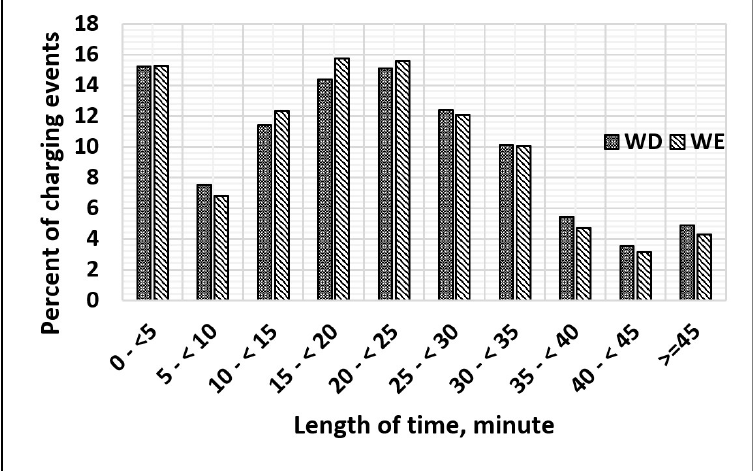
Figure 11. Distribution of length of time with a vehicle connected to an FCS per charging event [30].